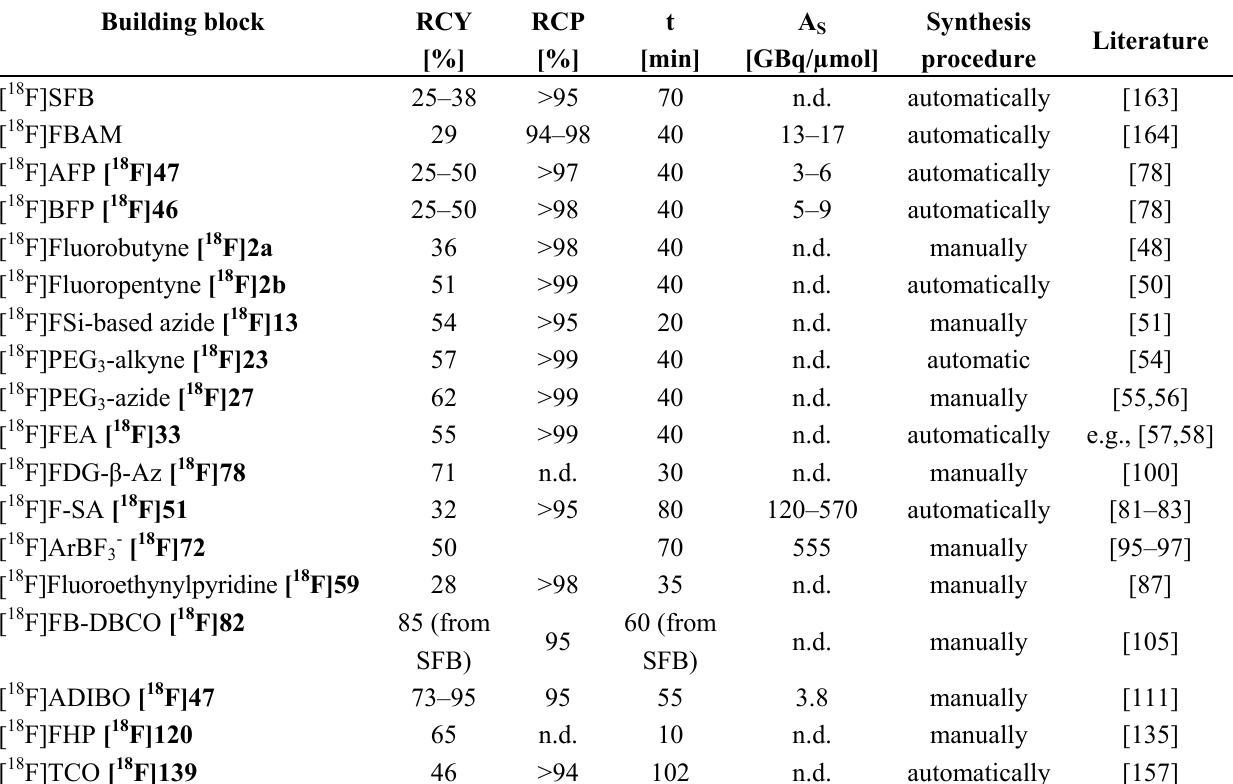
Table 5. Reaction conditions and yields of selected 18 F-containing building